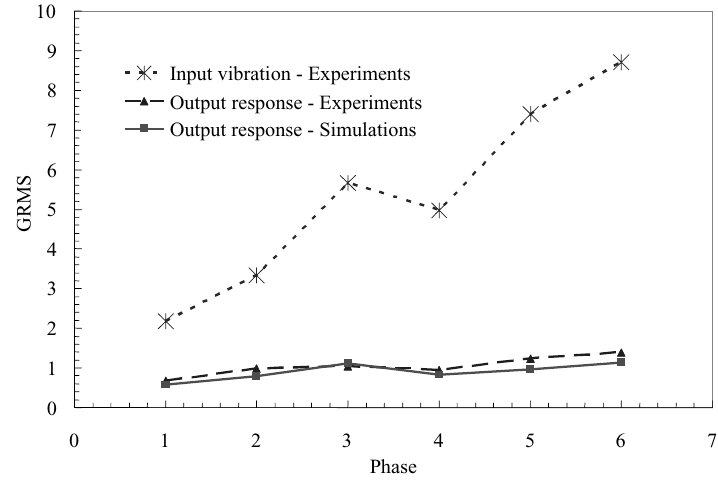
Fig. 21. Measured and predicted RMS